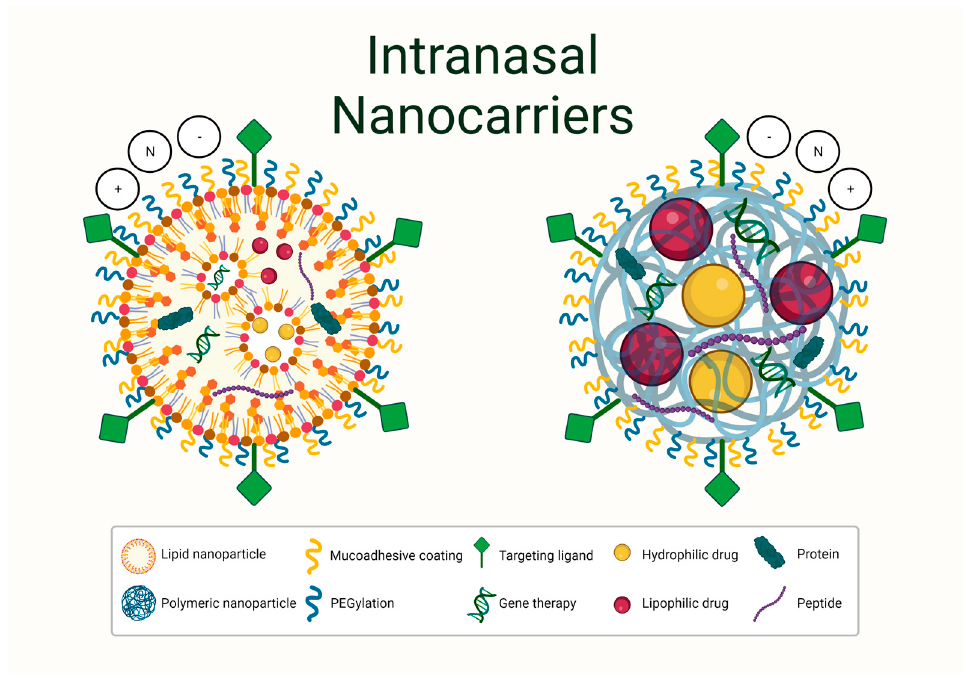
Figure 3. Both hydrophilic and lipophilic drugs as well as gene therapies, proteins and peptides can be encapsulated by SLNs and PLGA NPs. Both particle types can be conjugated with poly(ethylene glycol) (PEG) or saccharides to improve biocompatibility and/or targeting proteins or antibodies that bind to receptors located on endothelial cells of the BBB or within the brain parenchyma to enhance CNS uptake. SLNs and PLGA NPs can be synthesized with different surface charges. For intranasal delivery of NPs, a mucoadhesive coating is often used to enhance residence time in the nasal cavity which facilitates nose-to-brain transport (Created in BioRender.com; accessed on 2 Feb- ruary